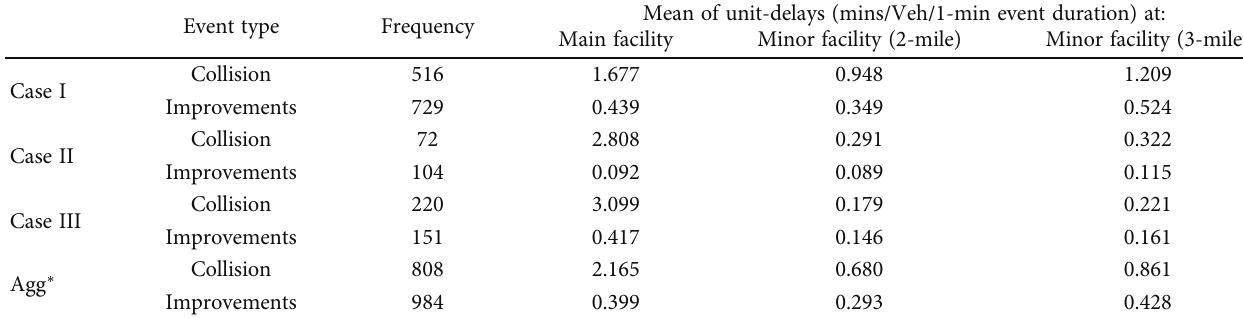
Table 11: Facility and Corridor Level Unit Delays by Event Type in the Aggregate and Across Case